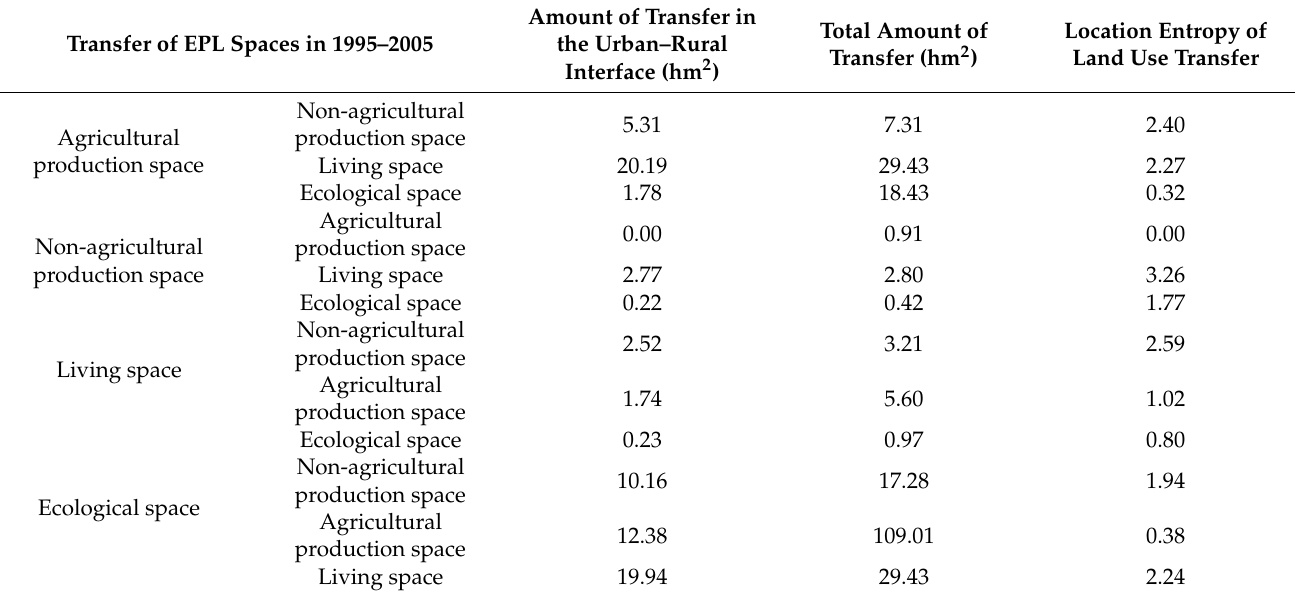
Table 9. Spatial transfer of EPL spaces in the urban–rural interface area from 1995 to